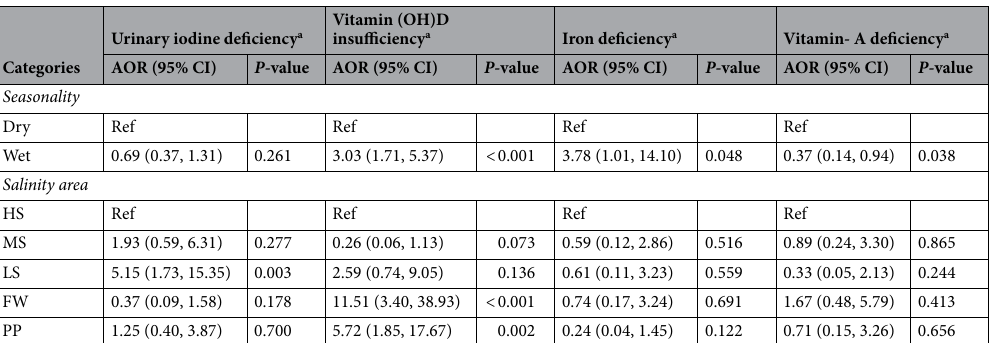
serum ferritin was significantly lower in the wet season (Coef: 0.79, 95% CI 0.71, 0.88; P < 0.001). Girls from PP areas were shown to have better ferritin status than those from HS areas. Even though there was a trend toward increased serum level concentration of vitamin (OH)D and ferritin during the dry season, mean serum retinol levels were noticeably higher than during the wet season. When compared to HS locations, the serum retinol level was significantly higher in MS areas. Table 3 demonstrates the risk factors identified by logistic regression for the micronutrient deficiencies. Iodine status of adolescent girls was unaffected by the season; their odds of having urinary iodine deficiency were 5 times higher in the LS than in the HS (AOR: 5.15, 95% CI 1.73, 15.35, P = 0.003) areas. We found a significant seasonal effect on the likelihood of vitamin (OH)D insufficiency among the adolescent girls. The odds of vitamin (OH)D insufficiency was 3 times higher (AOR: 3.03, 95% CI (1.71, 5.37), P < 0.001) in the wet season compared to the dry season. Girls who resided in FW regions had a five-fold increased risk of vitamin (OH)D deficiency compared to girls who lived in the HS areas (AOR: 4.9, 95% CI 2.3, 10.2; P < 0.001). The girls living in the FW and PP areas also had a higher risk of vitamin (OH)D insufficiency compared to the girls from HS area (FW, AOR: 11.51, 95% CI 3.40, 38.92, P < 0.001 and PP, AOR:5.72, 95% CI 1.85, 17.67, P = 0.002). The seasonal effect was also observed in the serum ferritin concentration of the girls; compared to the dry season, the risk of iron deficiency was around 4 times higher in the wet season (AOR: 3.78, 95% CI 1.01, 14.10; P = 0.048). However, salinity level was not associated with risk ID. In comparison to the dry season, girls had a lower risk of vitamin A deficiency during the wet season (AOR: 0.47, 95% CI 0.14, 0.94; P = 0.038).